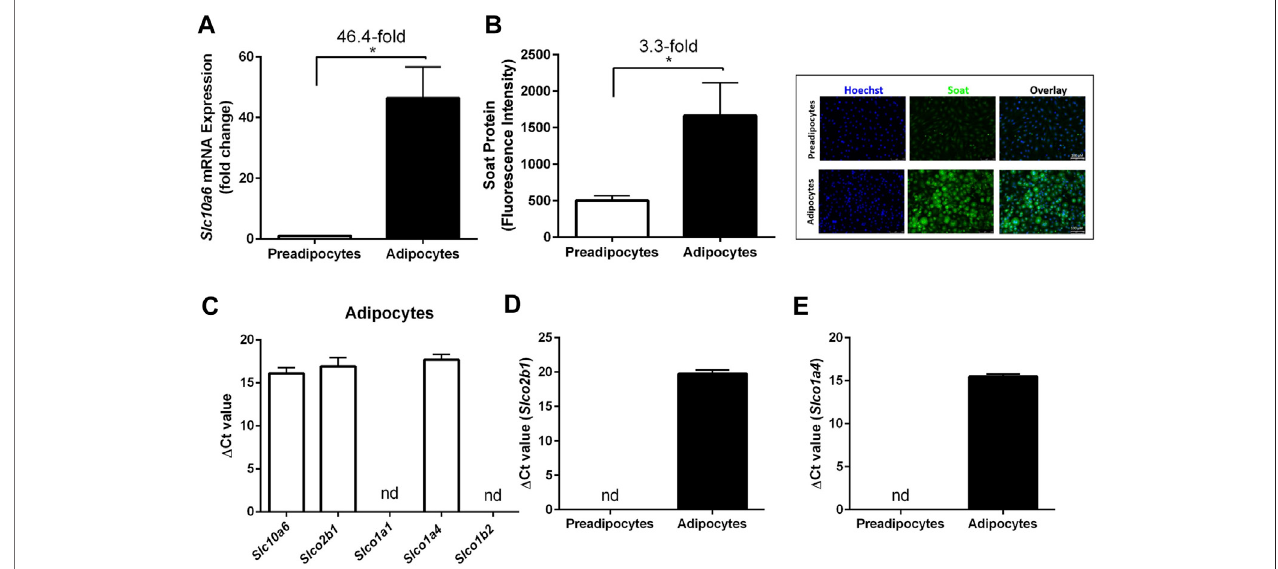
FIGURE3| ExpressionofSoat andother steroidsulfatetransportersin3T3-L1preadipocytesand adipocytes. (A) Slc10a6 mRNAlevelswerequanti fi edbyqPCR in 3T3-L1 preadipocytes and adipocytes using a Slc10a6 -speci fi c TaqMan probe. Gapdh expression was used to normalize Slc10a6 expression ( Δ Ct), and the Δ CT value in preadipocytes was set as the calibrator for 2 − ΔΔ Ct calculation of the fold expression change during adipocyte differentiation. (B) Anti-Soat immuno fl uorescence analysisand quanti fi cationof fl uorescenceintensityin3T3-L1preadipocytes and adipocytes. Datain (B) represent means±SDofthreeindependent areasofview (each with 60 – 74 cells) of three independent replicates. Representative immuno fl uorescence images of preadipocytes and adipocytes are shown. The cells were fi xed and stained with the anti-Soat antibody and the secondary Alexa Fluor 488 goat anti-rabbit antibody (green fl uorescence). Hoechst 33342 was used for nuclei staining (blue fl uorescence). (C) Expression pro fi le of 3T3-L1 adipocytes for different steroid sulfate uptake carriers. (D) Slco2b1 and (E) Slco1a4 mRNA expression in preadipocytes and differentiated adipocytes. Expression data in (C – E) are presented as Δ Ct values from qPCR analysis and represent carrier expression normalized to Gapdh expression. Data are expressed as means ± SD. *Signi fi cant differences between preadipocytes and adipocytes indicated by p < 0.05 according to Student ’ s